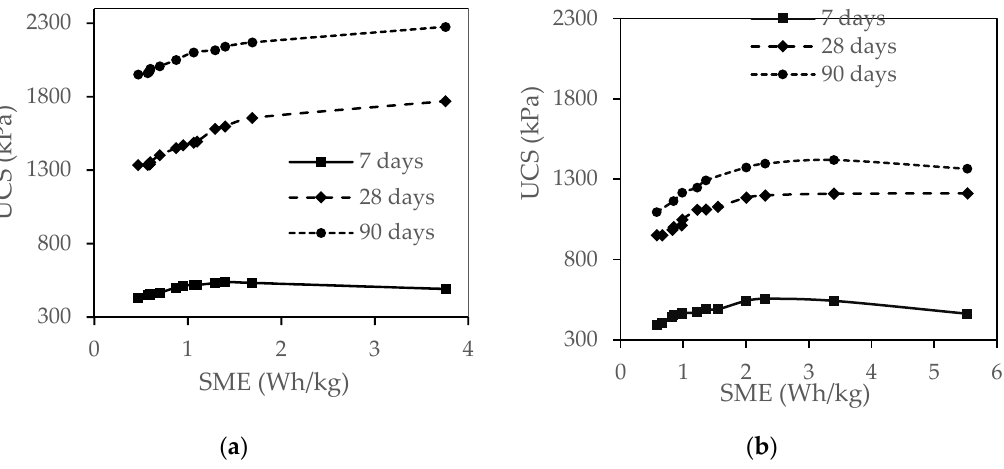
Figure 8. Effect of SME on UCS at curing times of 7, 28 and 90 days for: ( a ) CPB-T1 and ( b ) CPB-T2. For a given mixture, the increase of the UCS with the SME may also be explained by the bulk density of the cylindrical probes at a given curing time. Typical results are presented in Figure 9 for specimens used to determine the UCS of CPB-T1 and CPB-T2 at a curing time of 7 days.